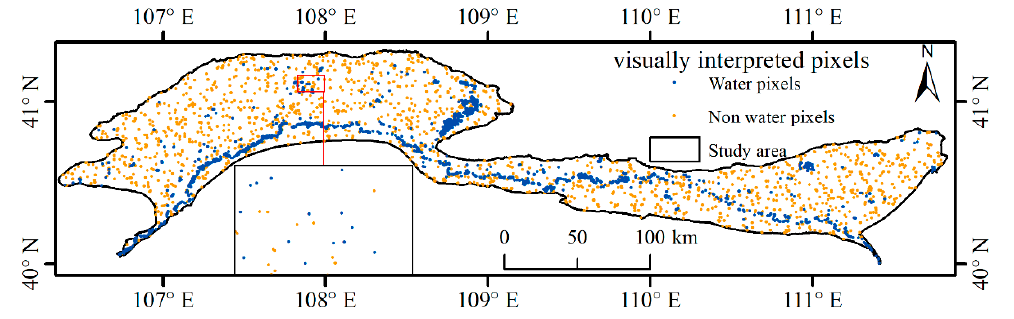
Figure 3. Verification points of the water bodies and non-water bodies.